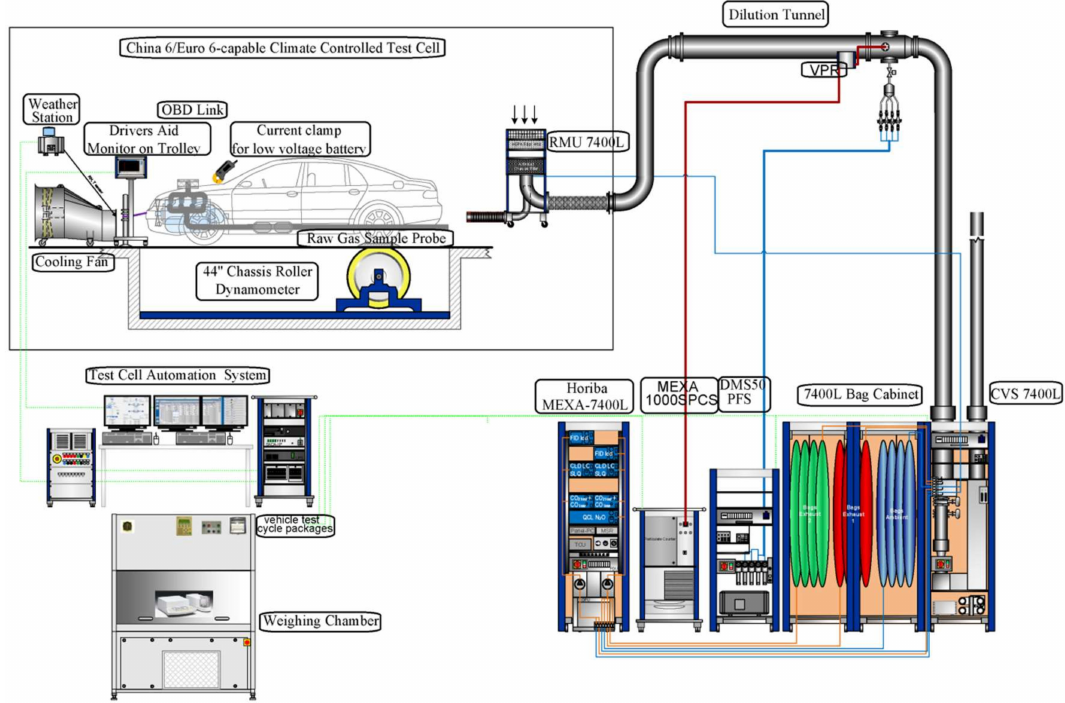
Figure 1. Chassis dynamometer and exhaust gas measurement